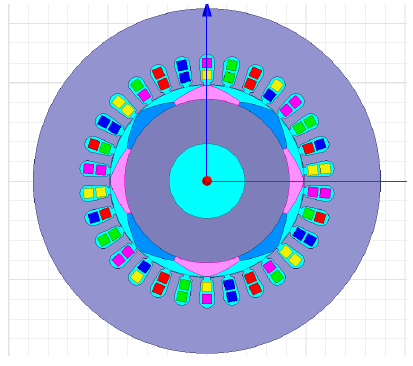
Figure 7. Motor structure.